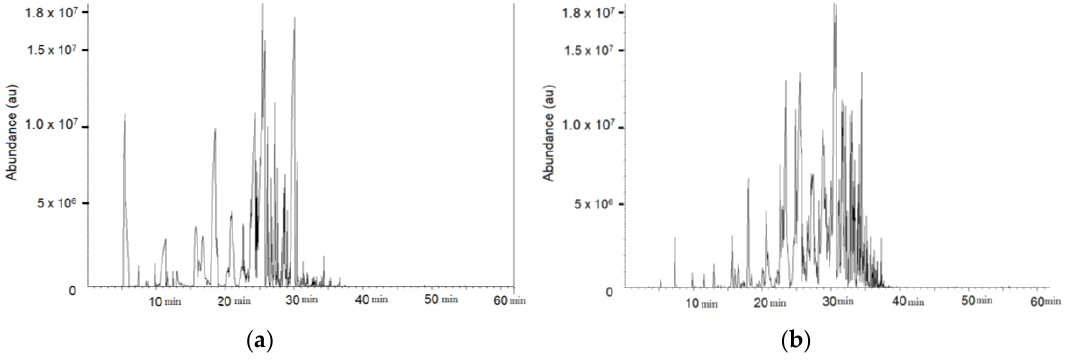
Figure 9. Results from GC-MS ( a ) spray paint ( b ) can paint ( x -axis represents retention time, y -axis